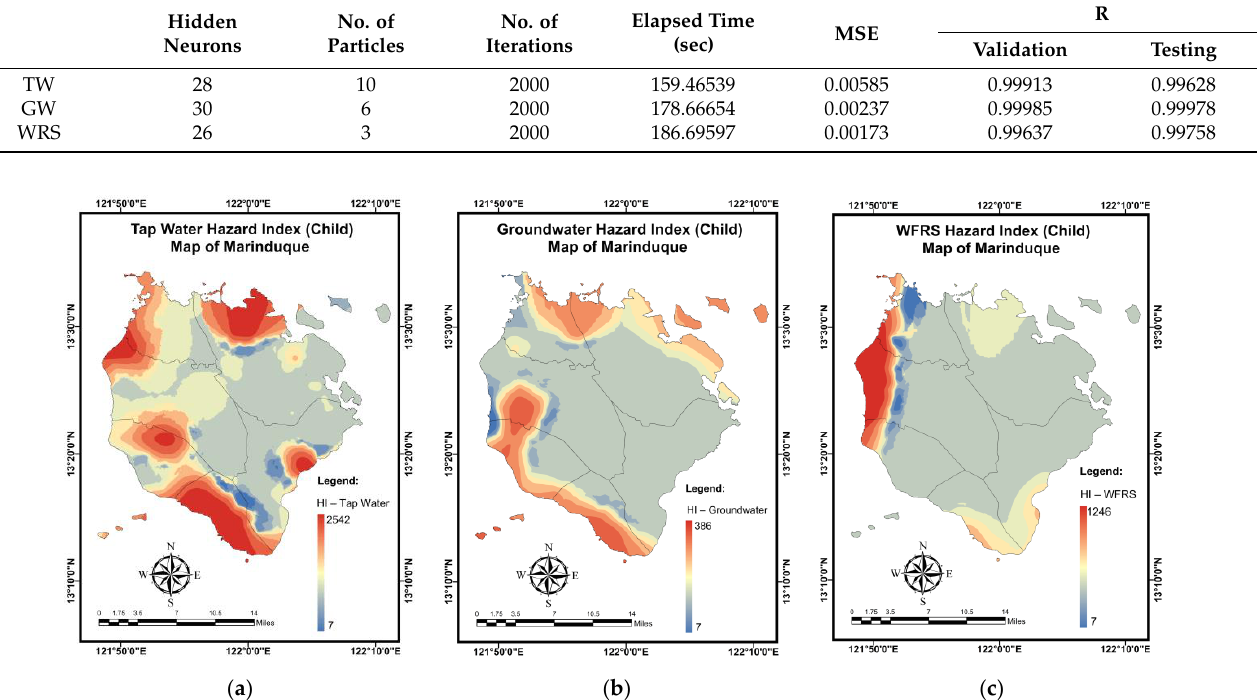
Table 14. NN-PSO simulation results for the HI (children) mapping of domestic water samples. Hidden Neurons Figure 16. Spatial maps of HI (adults) developed using MLGI approach for ( a ) TW samples, ( b ) GW samples, and ( c ) WRS samples.